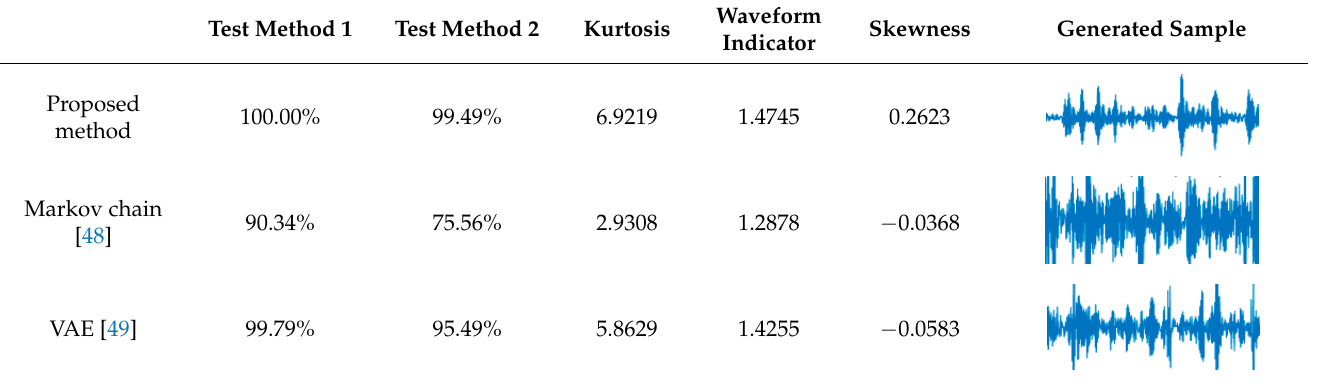
Table 9. Performance comparison of the three methods.